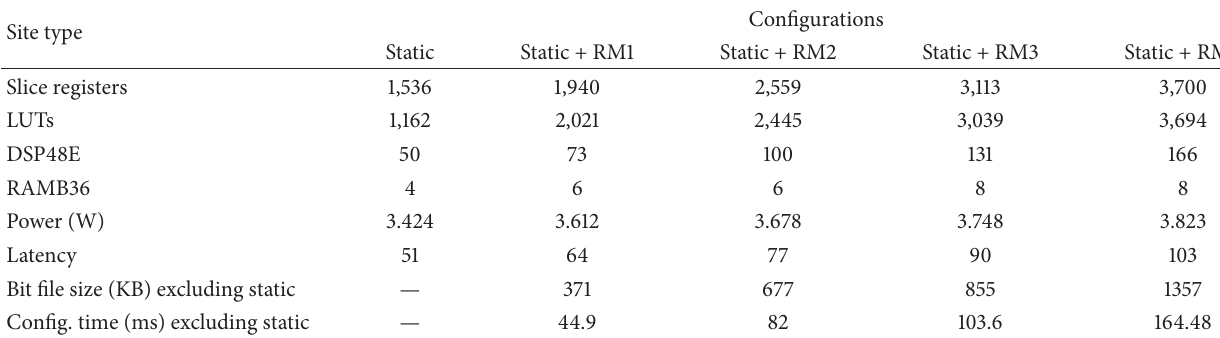
Table 4: Implementation results for scalable QRD